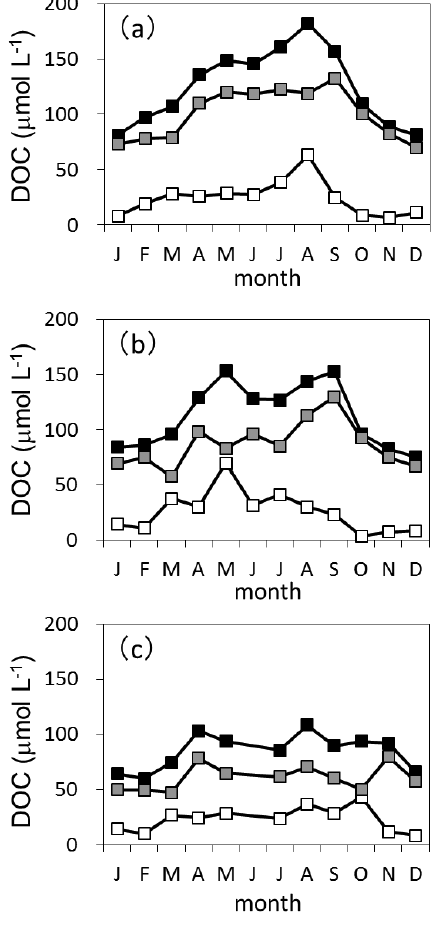
Figure 5. Seasonal variations in DOC (black square), bioavailable DOC (BDOC; white square), and recalcitrant DOC (RDOC; gray square) at stations (a) F3, (b) F6, and (c) 06. Error bars represent the standard